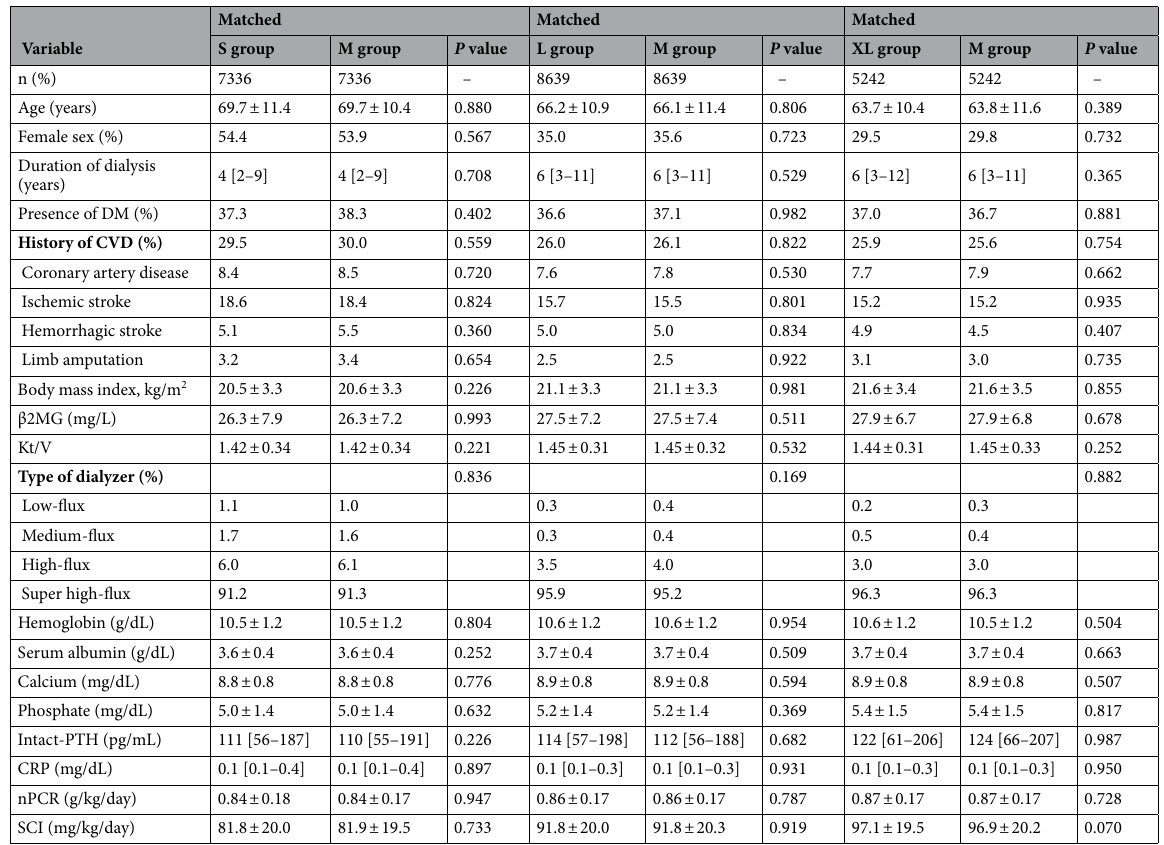
Table 4. Baseline characteristics after propensity score matching between the M (reference) group and other groups. Data are expressed as mean ± standard deviation (SD), number (%), or median